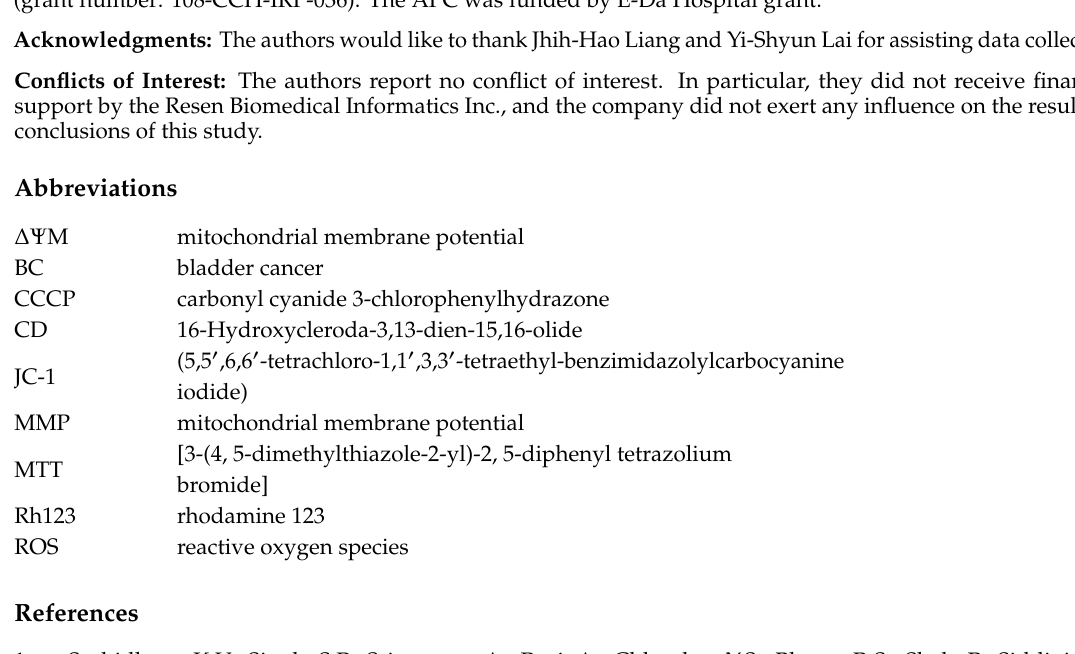
Supplementary Materials: The following are available online, Figure S1: The top 7 enriched KEGG pathways upon CD treatment. Table S1: Ranked di ff erential gene expression using confect